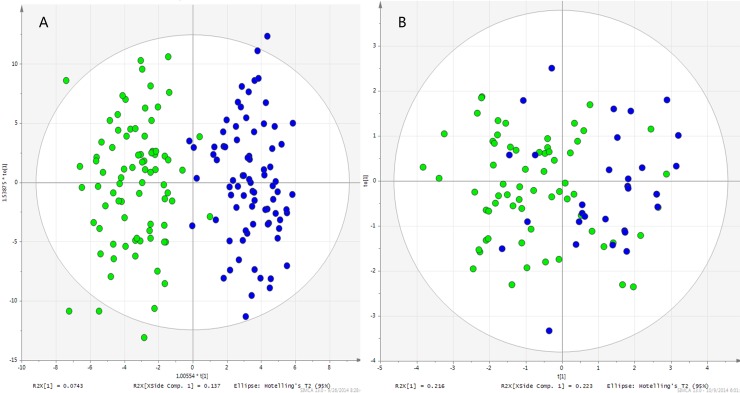
OPLS-DA score plot for training set.A. Generated with metabolomic profiling data; B. Generated with quality parameter of seminal plasma data.